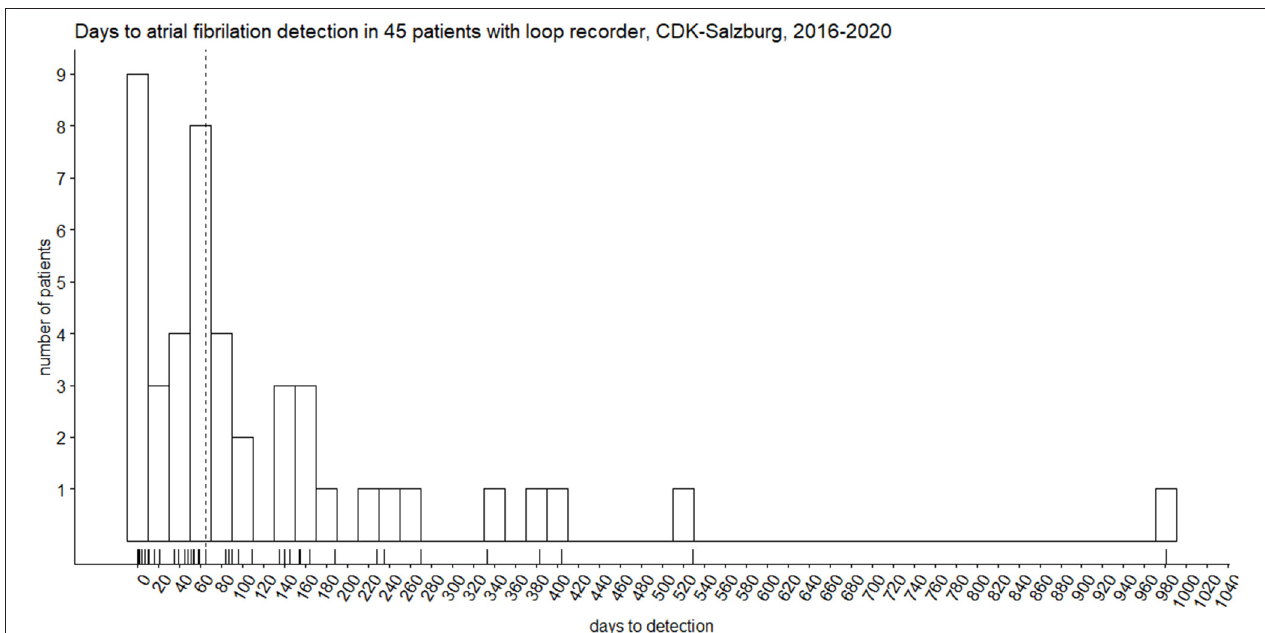
FIGURE 1 | Biphasic distribution of days to atrial fibrillation detection in 45 patients with Reveal LINQ® Medtronic implantable recorder. The vertical dotted line represents the median (65 days).